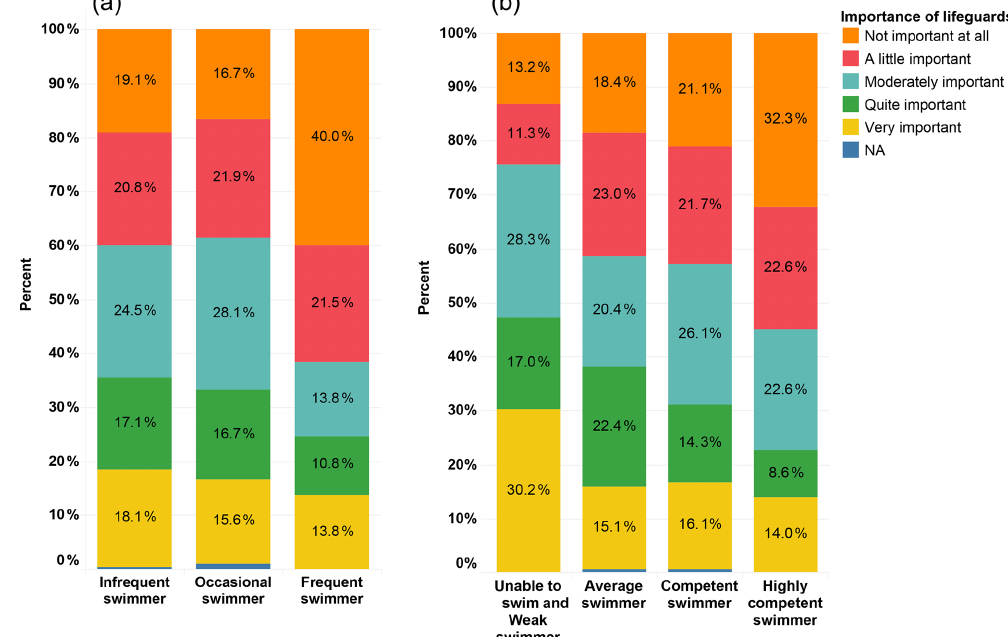
Figure 3. Beachgoers’ evaluation of the importance of lifeguards compared with their swimming frequency (a) and their swimming abil- ity (b) . Beachgoers who were unable to swim ( n = 6) and weak swimmers ( n = 46) were combined for ease of